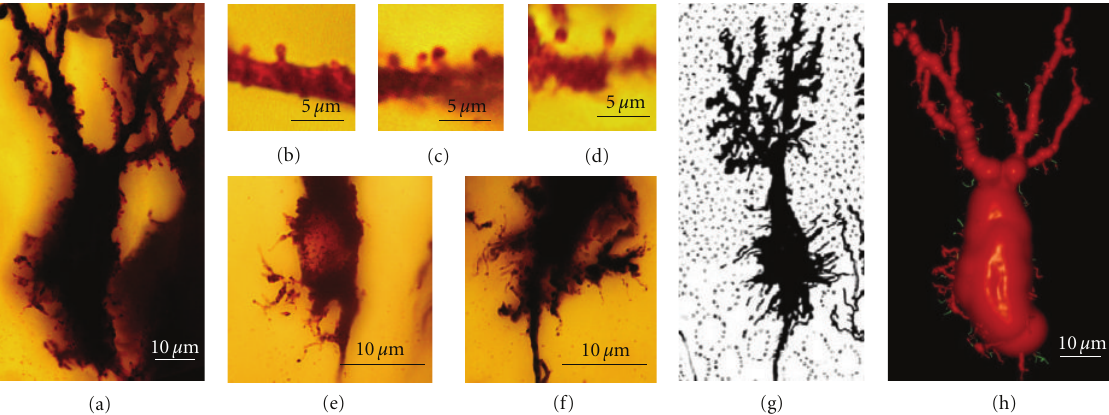
Figure 9: (a) Represents a Purkinje cell in the phase of dendritic regularization, cerebellum, new-born dog. Cajal histological preparation, Golgi method. (b, c) Dendritic spines of apical branches. (d) dendritic spines of lateral perisomatic branches. (e, f) Purkinje cells with perisomatic branches with filopodia near the axonal origin. (g) Cajal scientific drawing [7, Figure 417]. Purkinje cell, several days old dog. (h) Three-dimensional reconstruction of the Purkinje cell showed in (a); filopodia are color coded in